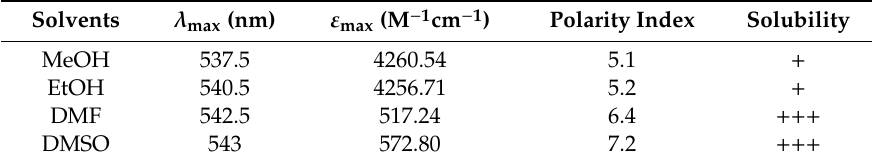
Table 1. Spectral properties and solubility of RhYK dye in various solvents.